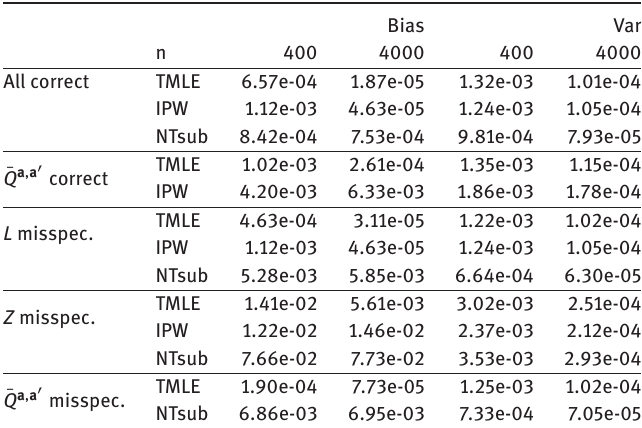
Table 1: Bias, variance and MSE over 1,000